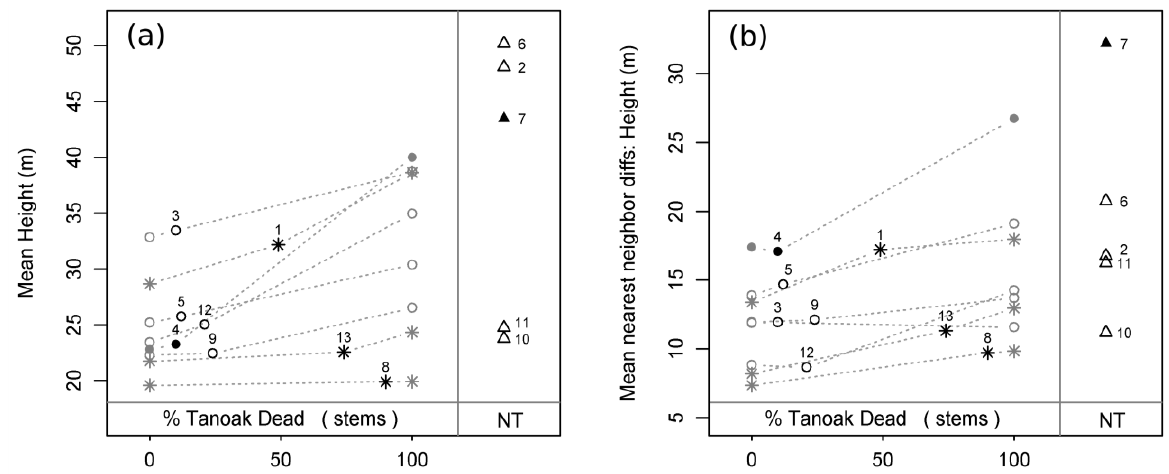
Figure 4. Mean height (a) and mean height difference between nearest neighbors (b) as a function of plot status and disease progression. Black numbered symbols represent present conditions of all 13 sampled plots: circles = healthy plots (H); stars = diseased plots (D), triangles = plots without tanoak (NT); open symbols = second growth plots; closed symbols = old growth plots. Grey symbols represent reconstructed pre-SOD conditions (0% tanoak dead) and projected future conditions (100% tanoak dead) for all plots with tanoak. Grey dotted lines connect each plot’s present condition to its respective pre-SOD and future conditions, thereby displaying predicted transitions for each plot. Plot ID numbers correspond to Table 1.